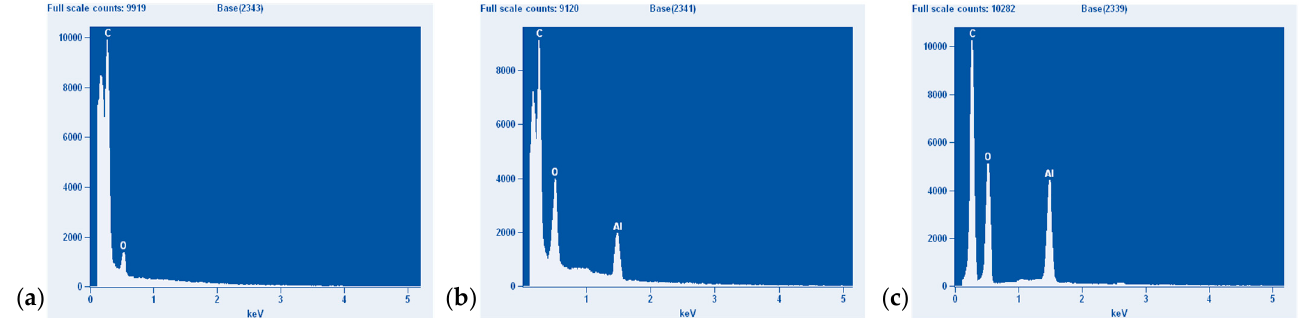
( c ) Figure 16. The fracture surface of resin with the addition of a filler 50 phr Al(OH) 3 . ( a ) Sample with